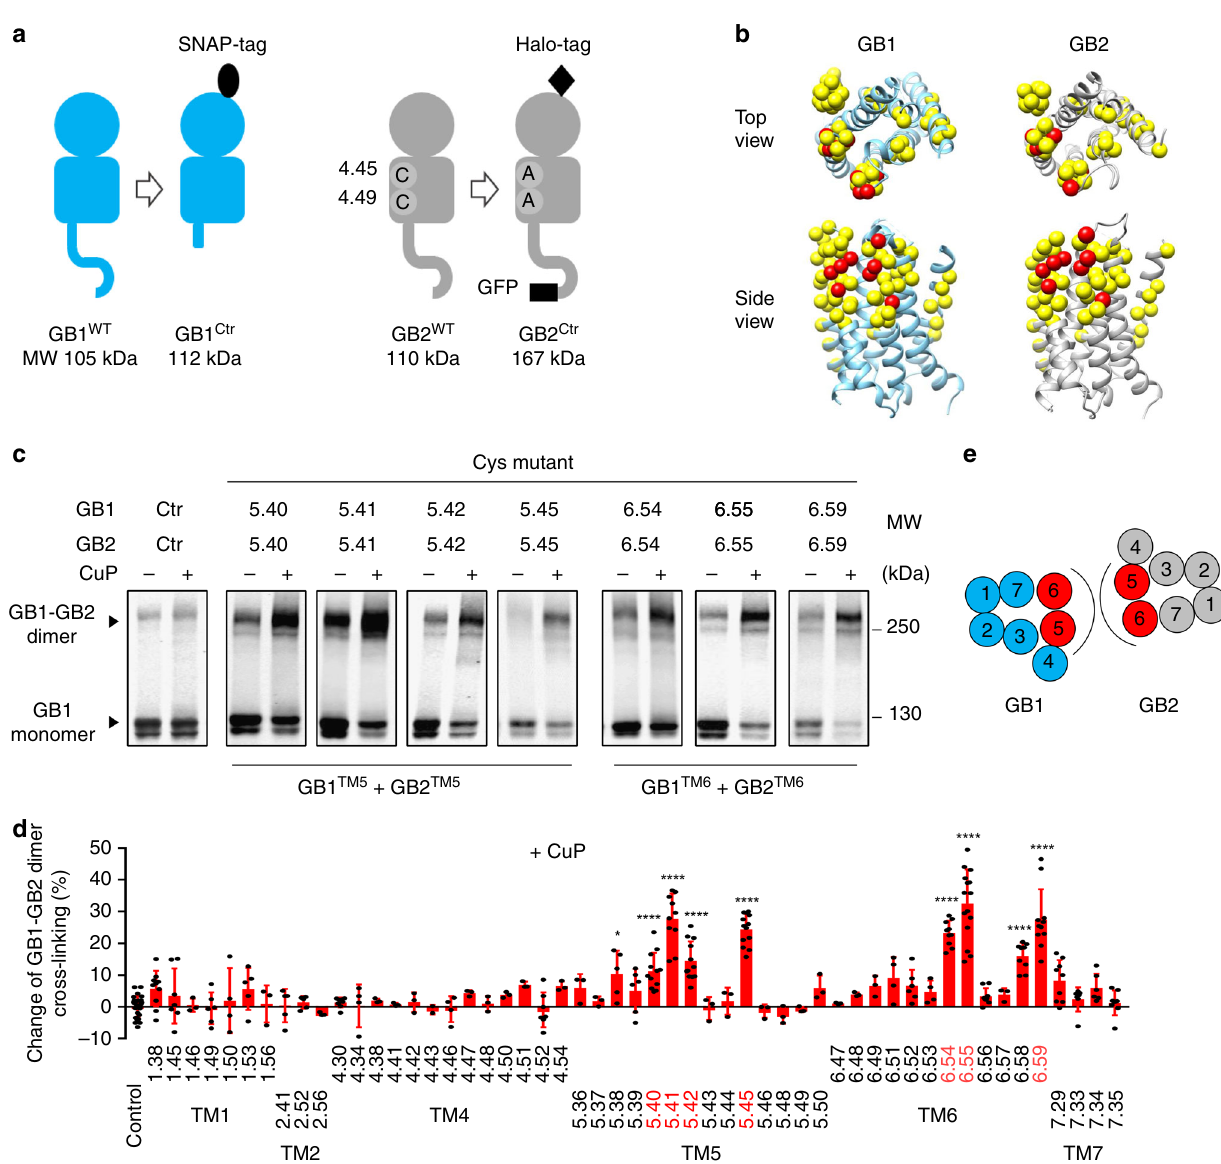
Fig. 2 Cysteine cross-linking identi fi es TM5 and TM6 at the 7TM heterodimer interface. a Schematic representation of the GB1 Ctr and GB2 Ctr constructs used in the study. To easily distinguish GB1-GB2 and GB1-GB1 cross-linking in SDS-PAGE experiments, the molecular weight of the two subunits was modi fi ed. The SNAP-tagged full-length GB1 was truncated in the C-terminal region downstream of the coil-coiled region. Halo-tagged full-length GB2 was enlarged by adding a GFP tag at the C-terminal end of the subunit. To prevent the endogenous Cys producing unwanted disulphide bridges, the two indicated Cys residues in GB2 TM4 were changed to alanine. b 3D model of the 7TM of GB1 (blue) and GB2 (grey). All cysteine substitutions are highlighted by a yellow ball ( α carbon), and those that cross-linked well in TM5 and TM6 (see panel c ) by a red ball. c Cross-linking of the indicated cell surface SNAP- GB1 subunits labelled with fl uorescent SNAP substrates, after treatment ( + ) or without treatment ( − ) with CuP. After SDS-PAGE in non-reducing conditions, GB1 monomers and GB1-GB2 dimers were detected via the fl uorophore covalently attached to the receptors. MW, molecular weight. Data are representative of a typical experiment performed three times. d Change of GB1-GB2 dimer rate induced by CuP treatment for the “ Control ” heterodimer (GB1 Ctr co-expressed with GB2 Ctr ) and every indicated mutant (both GB1 and GB2 subunits having a Cys residue in the same position). Positions with a signi fi cant change were highlighted in red. Data are mean ± SD from at least three independent experiments ( n = 3 – 6). Unpaired t test with Welch ’ s correction with **** P < 0.0001 and *** P < 0.001, the other data being not signi fi cant. e Dimerization interface based on the results of the cross-linking experiments in the absence of ligand. TMs that can cross-link between GB1 and GB2 are highlighted in